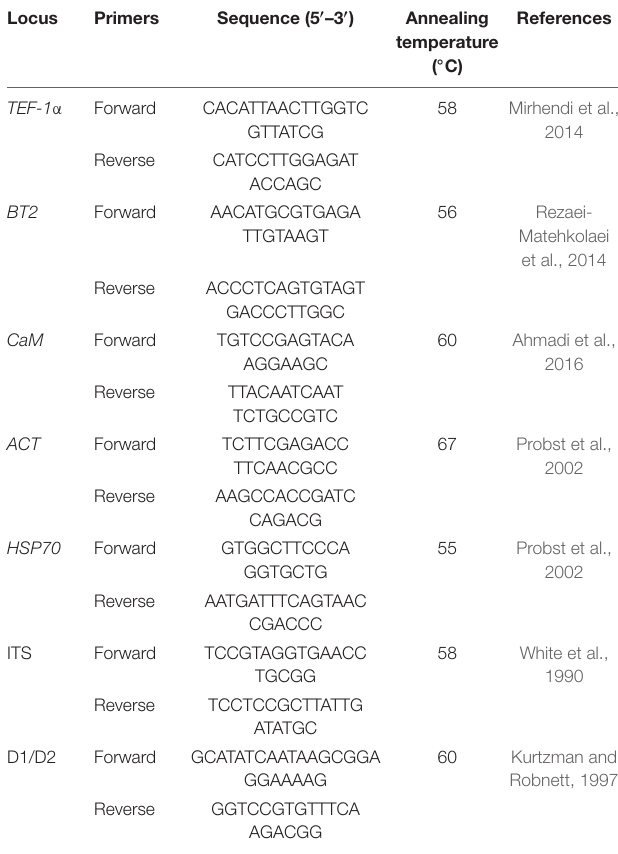
TABLE 1 | Oligonucleotide primers used for the molecular identification of dermatophytes. Locus